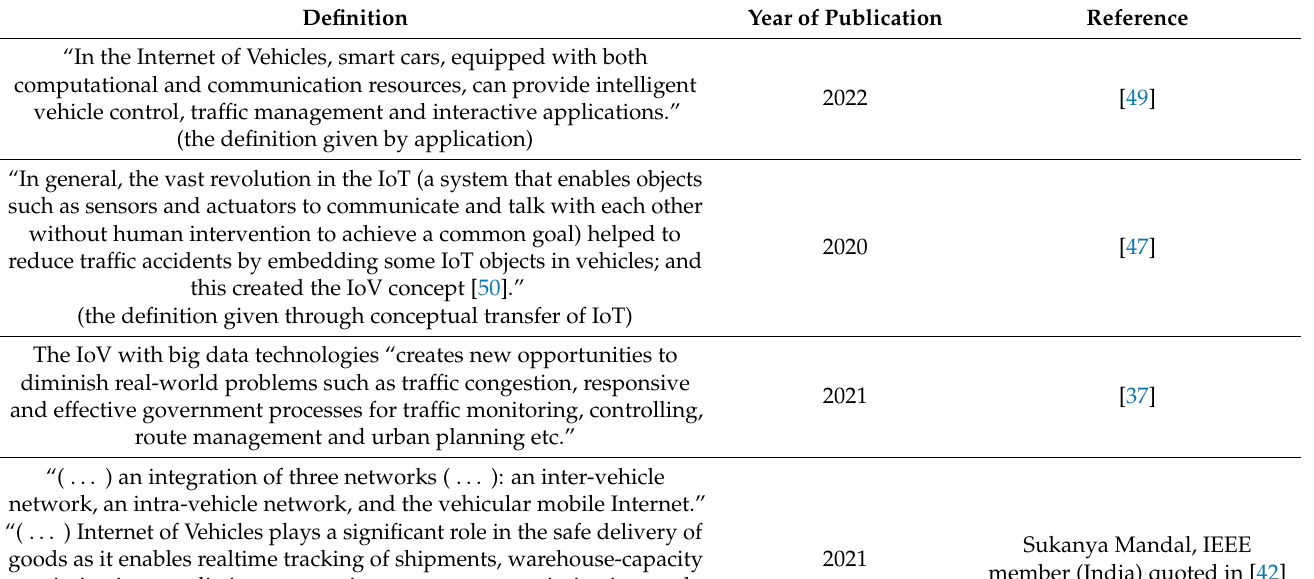
Table 1. Definitions of